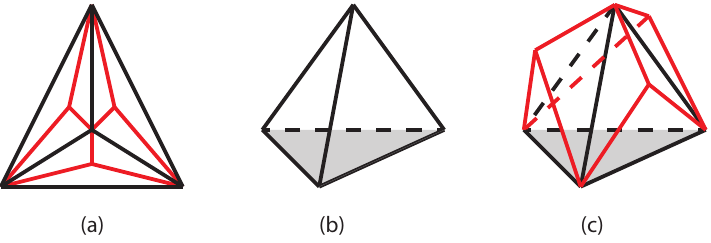
Figure 1. Apollonian network: ( a ) first (black) and second (black and red) generations of the Apollonian network; ( b ) first generation of the same Apollonian network represented as a tetrahedron in 3-dimensional space; ( c ) Apollonian networks of higher generations can be thought of as rooted trees constructed from adjacent tetrahedra. Here, second generation is shown; the shaded face functions as a root of the